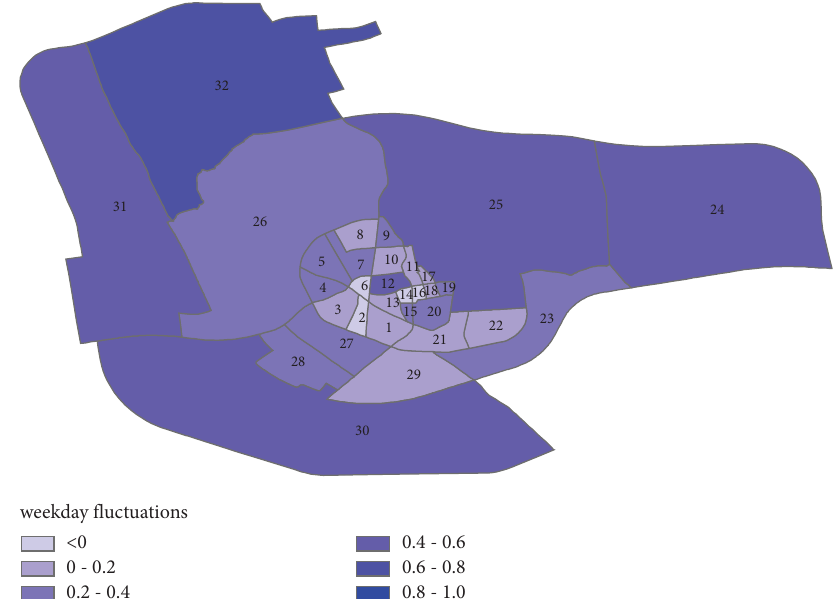
Figure 2: Average weekend travel fow